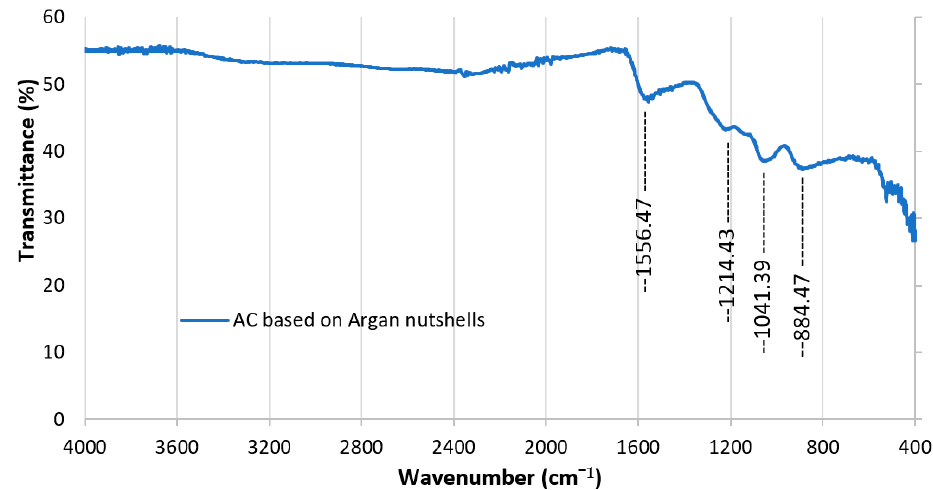
Figure 4. FTIR spectra of activated carbon from argan nutshells.